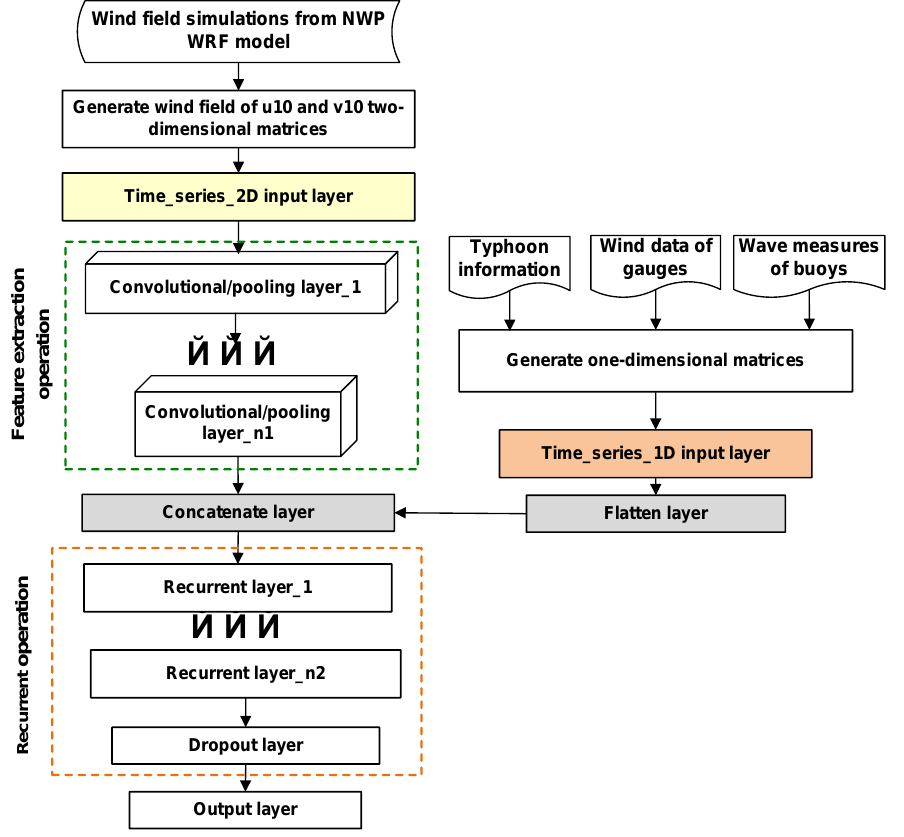
Figure 2. Artchiteture of an NUM–AI-based prediction model constructed with convolutional and recurrent neural networks and using numerical weather model